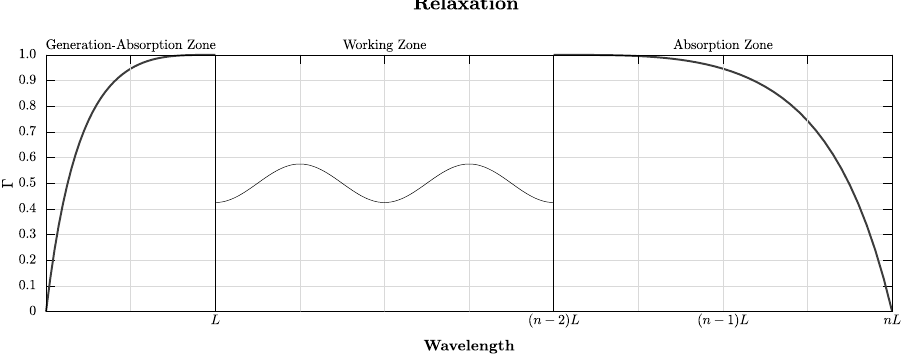
Figure 1. Sketch of an NWT with wave generation and absorption zones and relaxation functions where L is the incident wavelength and n is an